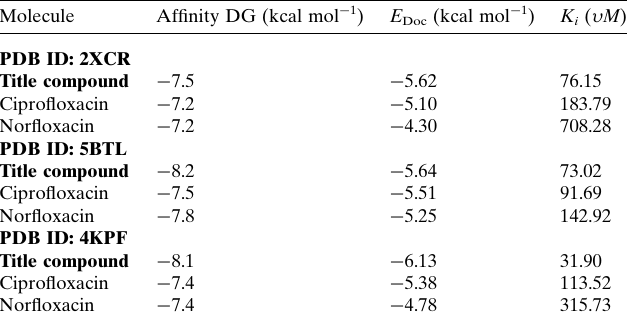
Table 2 The values of affinity DG, free binding energy, and binding coefficients for the best conformational positions of the title compound in combination with biotargets (PDB ID: 2XCR, 5BTL, 4KPF). Values are also given for reference